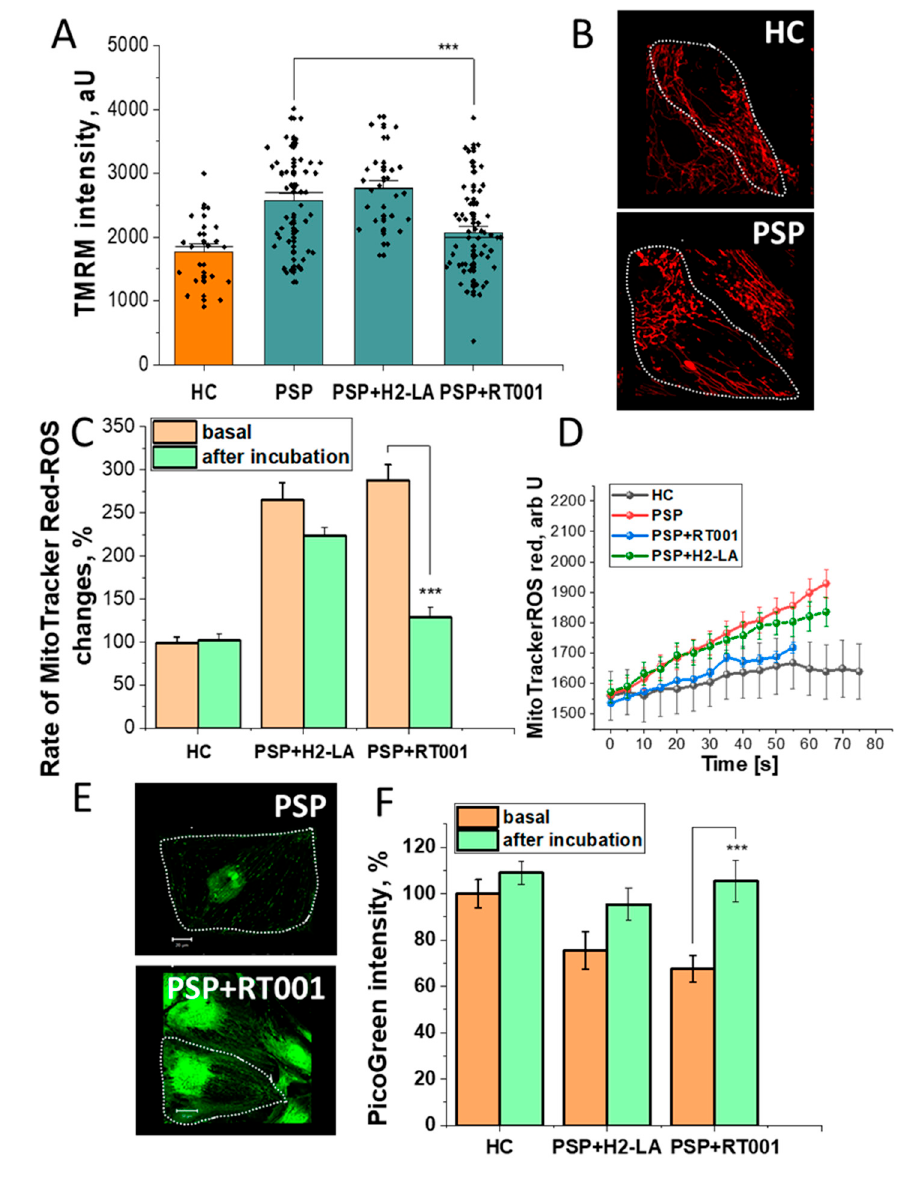
Figure 2. Protective effects of RT001 on mitochondrial function in PSP-MSCs. ( Panel A ) Histogram demonstrating the mitochondrial membrane potential ( ∆ ψ m) measured using the fluorescence intensity of TMRM (tetramethylrhodamine). ∆ ψ m was increased in PSP MSCs compared to HC. ∆ ψ m was reduced after incubation with RT001, but not after incubation with H2-LA ( p = 0.0009). ( Panel B ) Representative images depicting the mitochondrial shape, distribution, and fluorescence intensity at baseline for HC and PSP MSCs (fine dash line represents the approximate cell border of a MSC). ( Panel C ) Quantitative histogram of MitoTrackerCM-H2Xros fluorescence intensity shows baseline elevations in ROS in the PSP MSCs were reduced to near normal levels after incubation with RT001 ( p < 0.0001), but not after incubation with H2-LA ( p = 0.0801). ( Panel D ) MitoTrackerCM- H2Xros fluorescence over time for HC, baseline PSP, PSP + RT001, and PSP + H2-LA. Baseline fluorescence elevations for the PSP MSCs over HC MSCs were restored to near normal after RT001, but not after H2-LA incubation. ( Panel E ) Representative images of the mitochondrial DNA content of PSP MSCs at baseline (top panel). ( Panel F ) Quantification bar chart of the PicoGreen Intensity as a measure of mitochondrial DNA content. Baseline (orange columns) reductions in